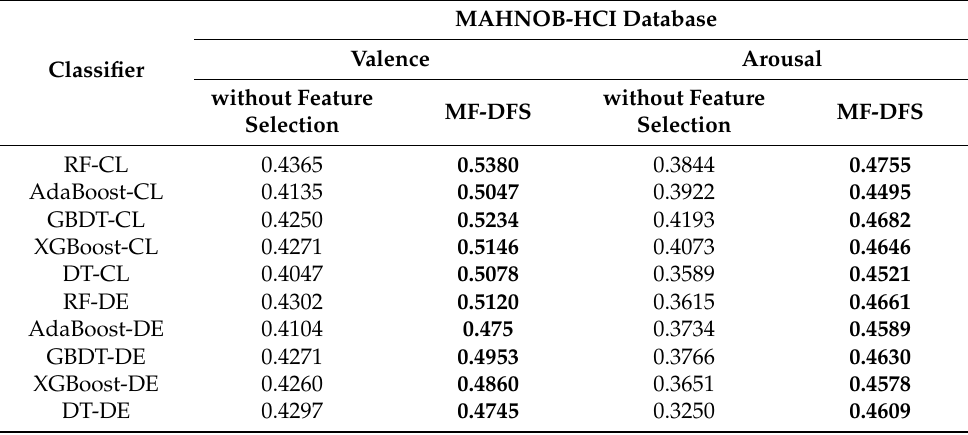
Table 8. Classification accuracy comparison across different machine learning methods in two different feature sets on the MAHNOB-HCI database.